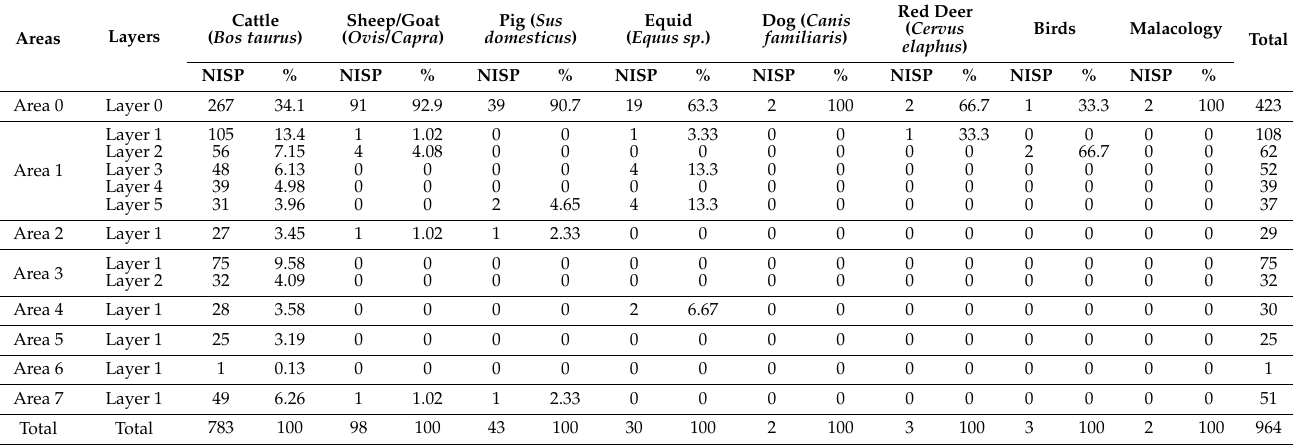
Table 1. Distribution of faunal remains from Stratigraphic Unit 1700 of the Vilauba pit by areas and layers. Areas